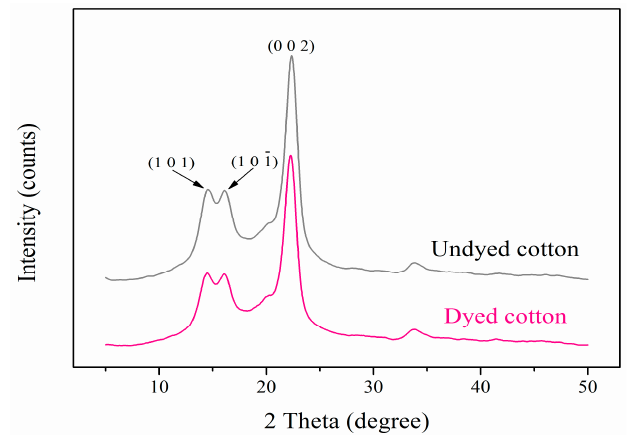
Figure 7. XRD patterns of undyed and dyed (pH 3.3) cotton fabrics.